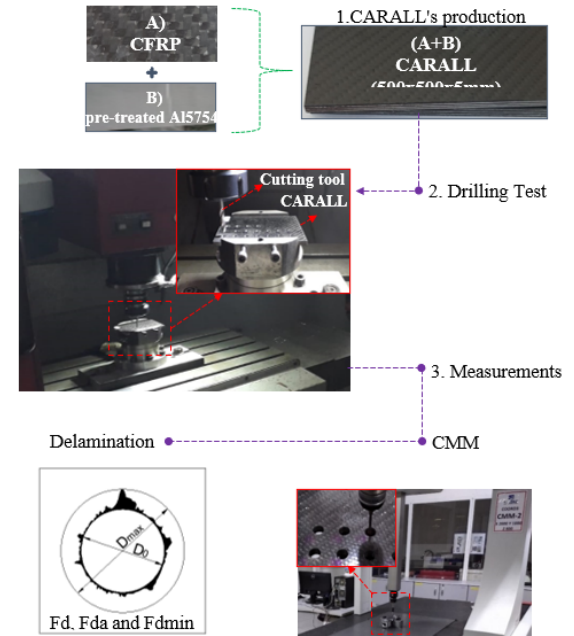
Figure 1. Flow chart of experimental setup and measu– rements